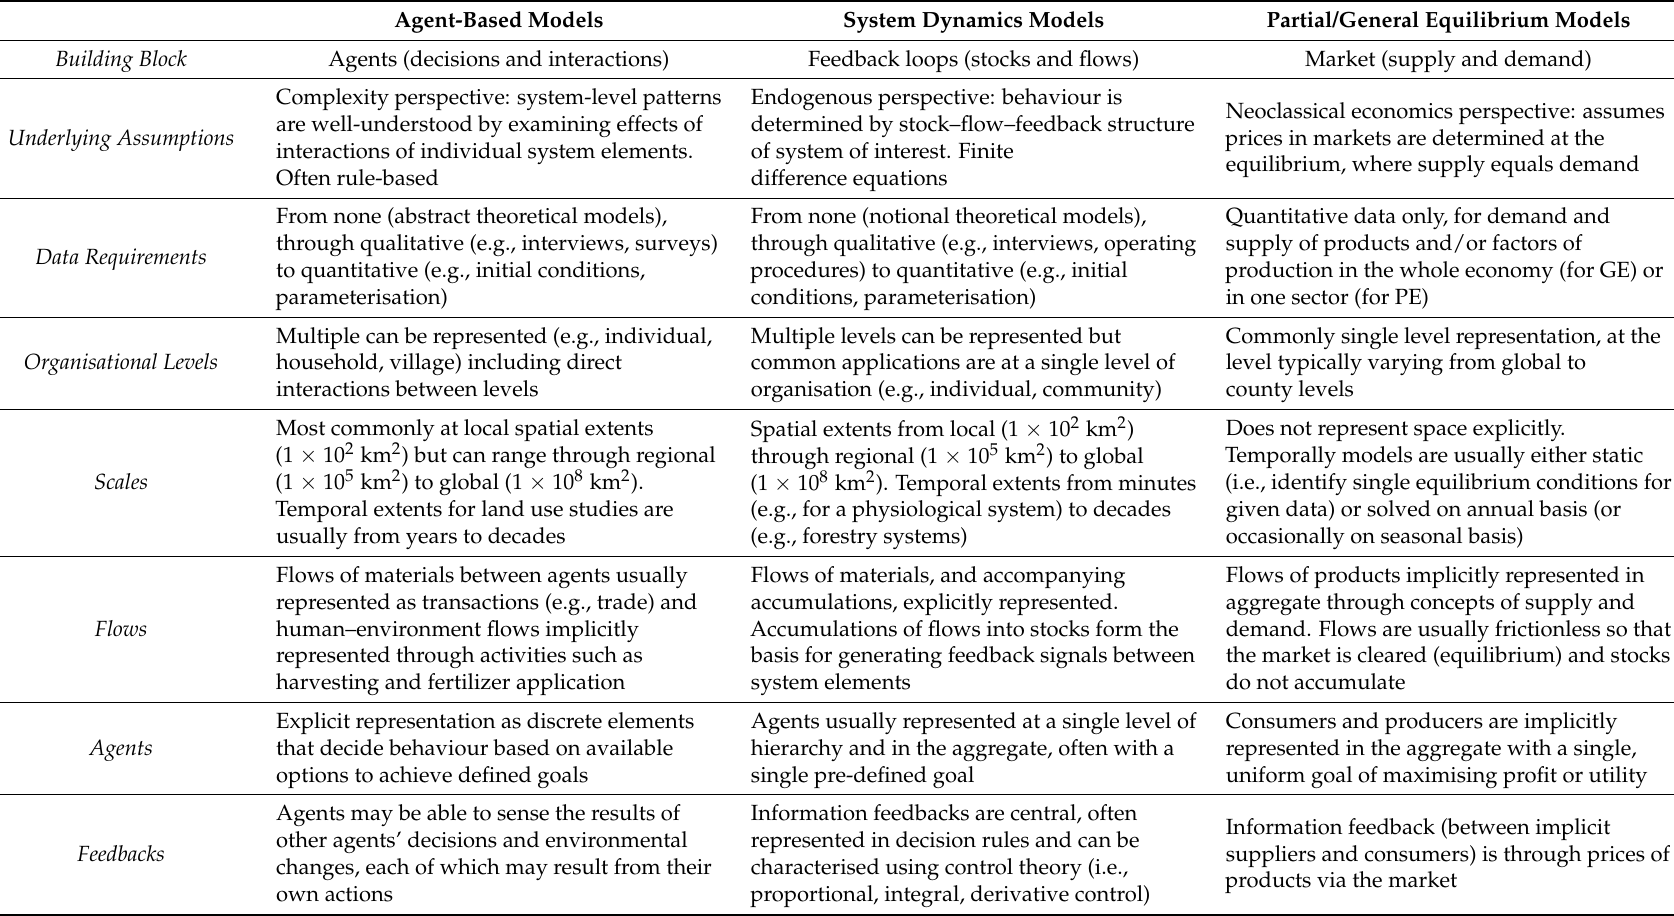
Table 1. Summary of three possible modelling approaches for representing telecoupled systems. The characteristics considered are the key differences between the model types of relevance for developing hybrid simulation models and are discussed further in the